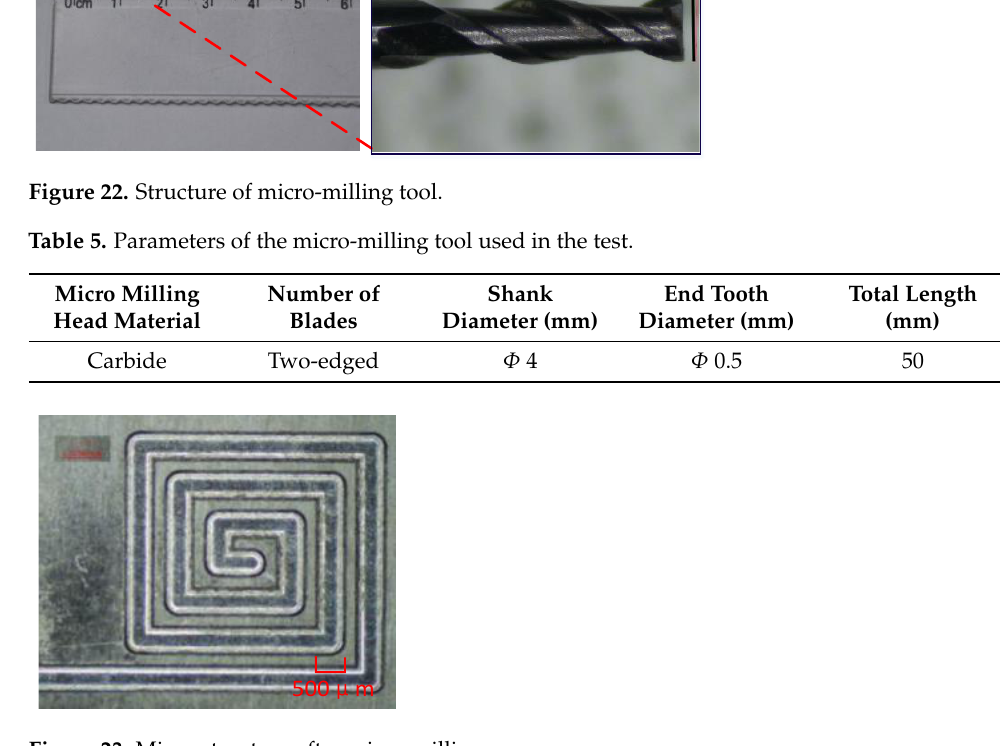
Table 6. Parameters of the micro-grinding rod used in the test.